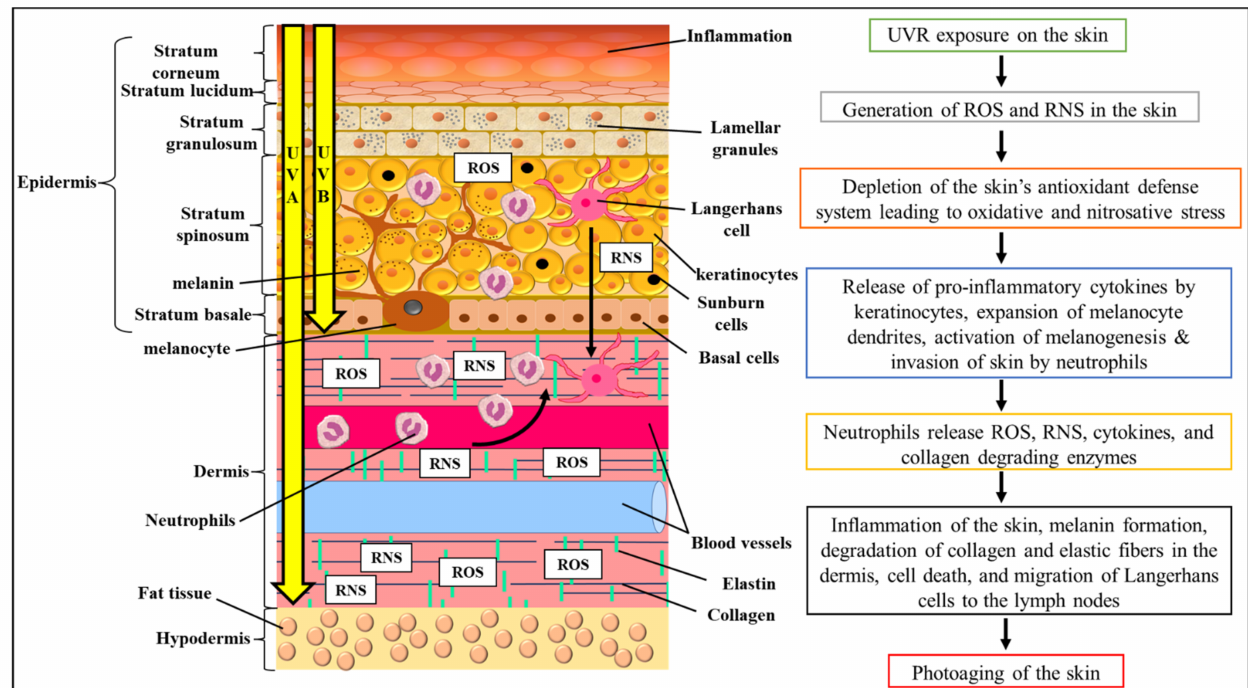
Figure 2. The impact of UVR exposure on the skin and how it mediates